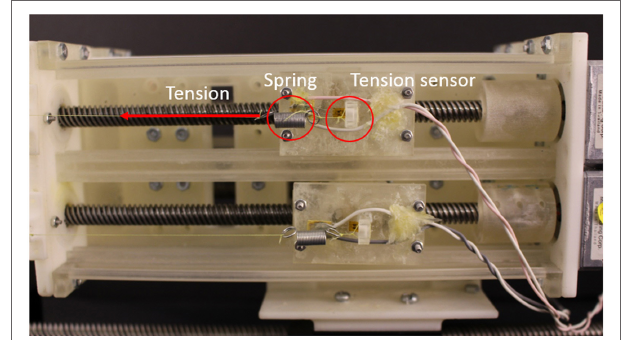
FigUre 5 | integrated linear actuator with tension sensor and spring